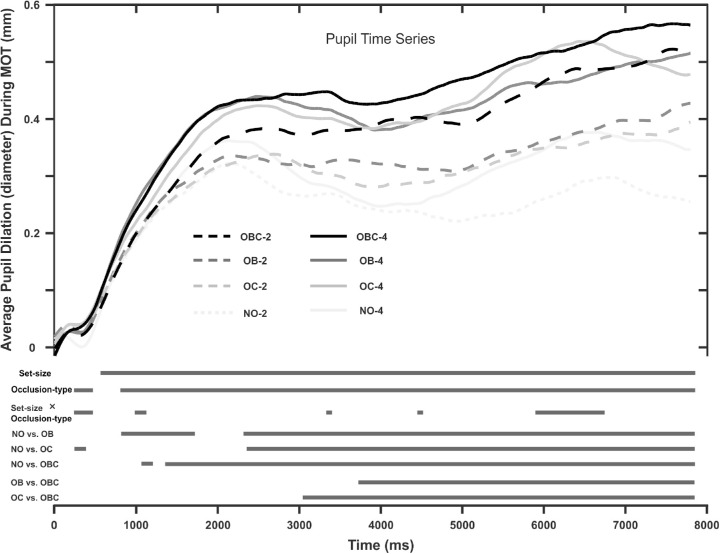
Average pupil size difference to the baseline during tracking (the upper curves). The bars below the curves show the time points during which the main effect of occlusion type and set size as well as their interaction were statistically significant. It also shows the time points during which the pairwise comparisons between the occlusion conditions were significant. OB = object-object occlusion; OC = object-occluder occlusion; OBC = object-object + object-occluder occlusion.